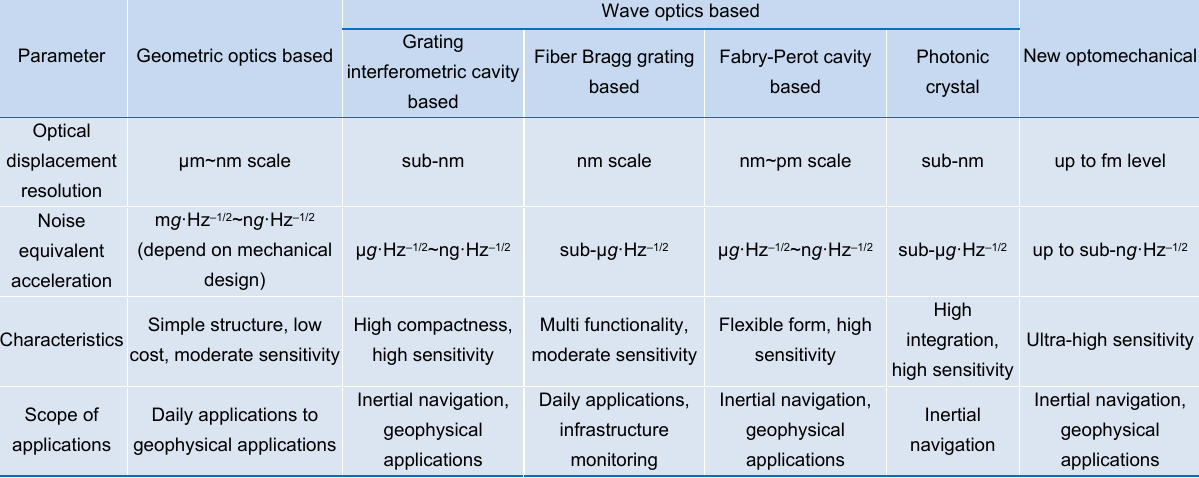
Table 1 | Typical specifications of various MOEMS accelerometers along with their characteristics and applications